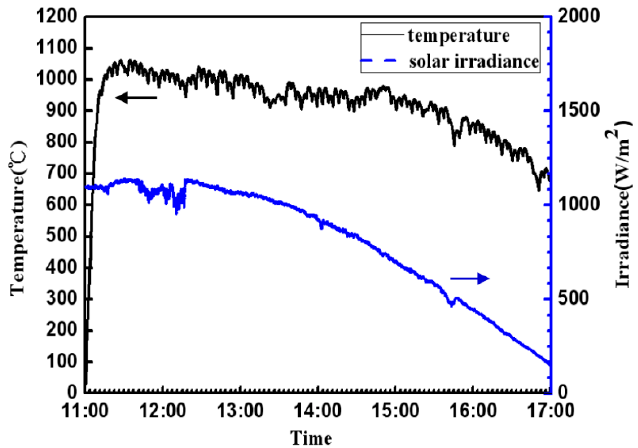
Figure 4. The power of sunlight and the temperature of the copper heating head with thermal insulation